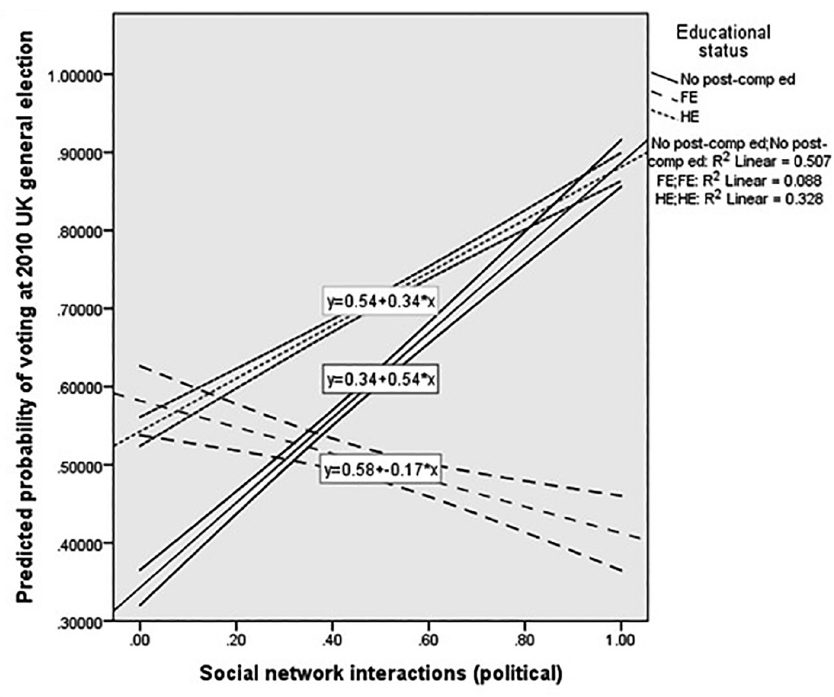
Figure 6: Mean predicted probability for 2010 General Election turnout by social network interactions and educational